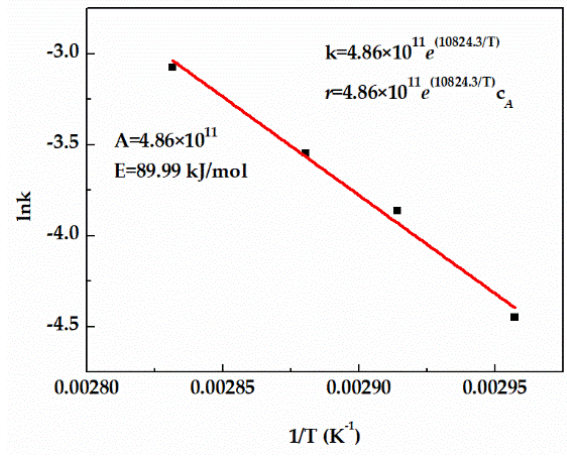
Figure 4. Effect of temperature on reaction rate constant.